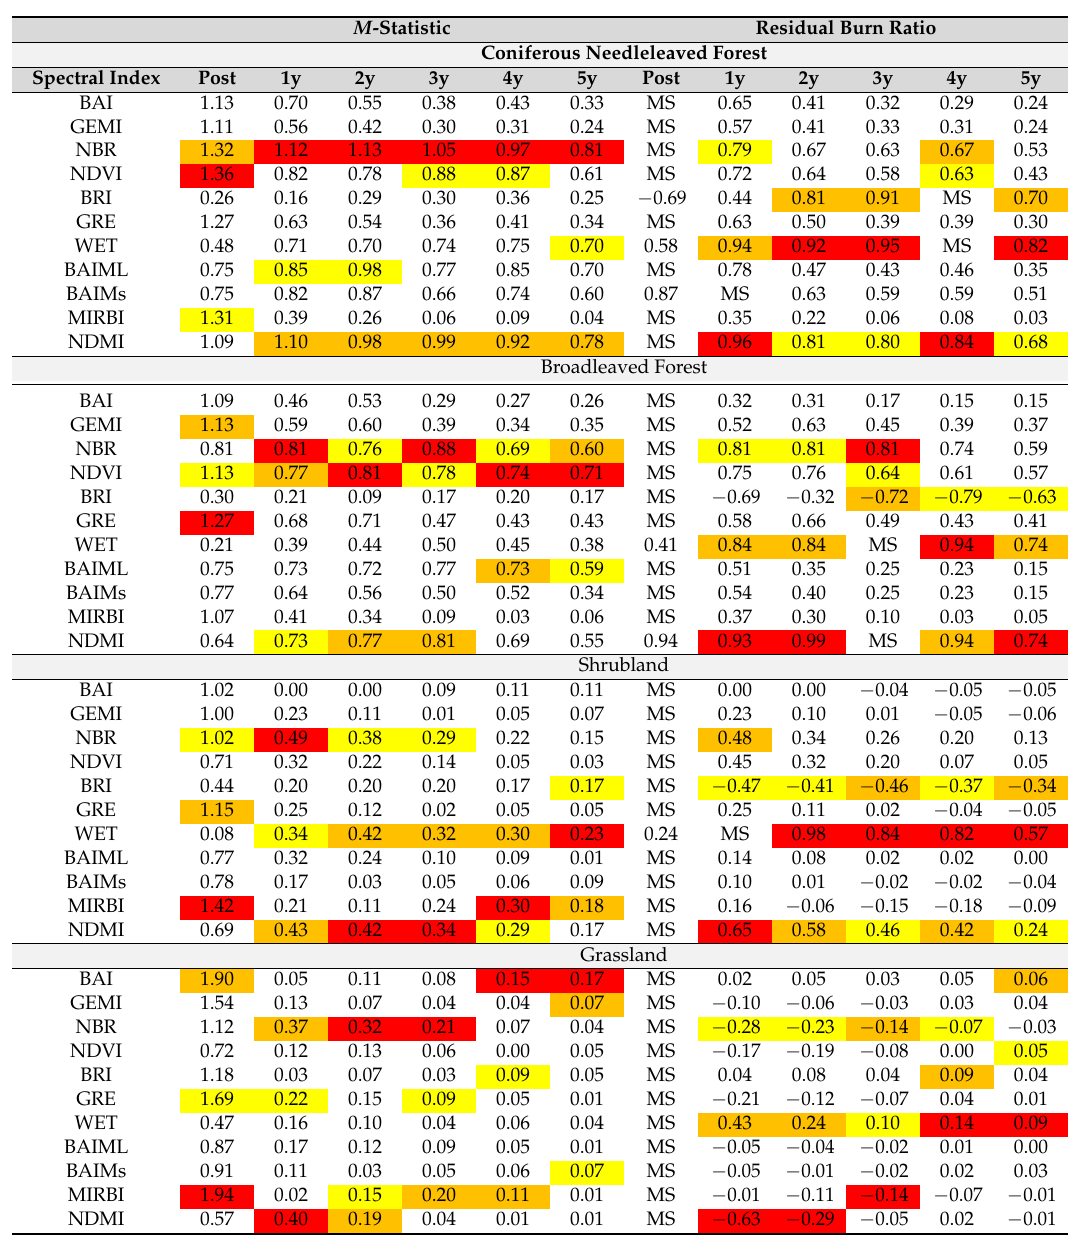
Figure 4. Spectral Indices’ trajectories over time: pre- and post-fire, and 1, 2, 3, 4, and 5 years following the fire. The plots represent the SI mean values for the burned and the reference samples of the whole dataset. Table 3. Separability index ( M -statistic) and Residual Severity Ratio ( RSR ) for the 11 SI. Highlighted cells indicate the three best performers at the given post-fire time in the following rank/color order: 1st, 2nd, 3rd. Pre-fire M -statistic values are shown as reference. MS = maximum severity from which RSR is calculated. Negative values of RSR indicate that the trajectory of the burned class crossed the trajectory of the unburned control class.